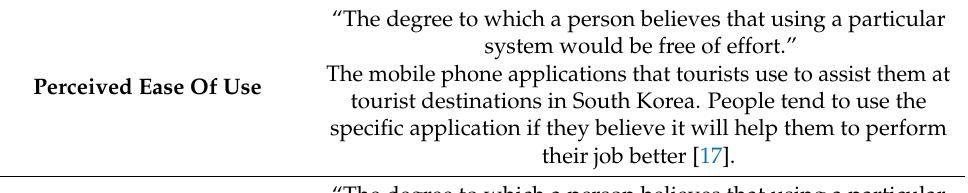
Table 1. Variables’ structures and concepts applied.